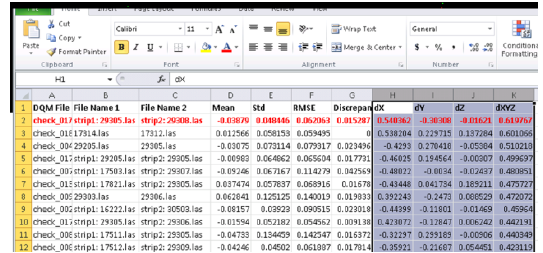
Figure 9. A sample excel sheet showing the summarizing of the results. The excel sheet shows the vertical, horizontal errors, systematic errors present between all overlapping swaths in a complete